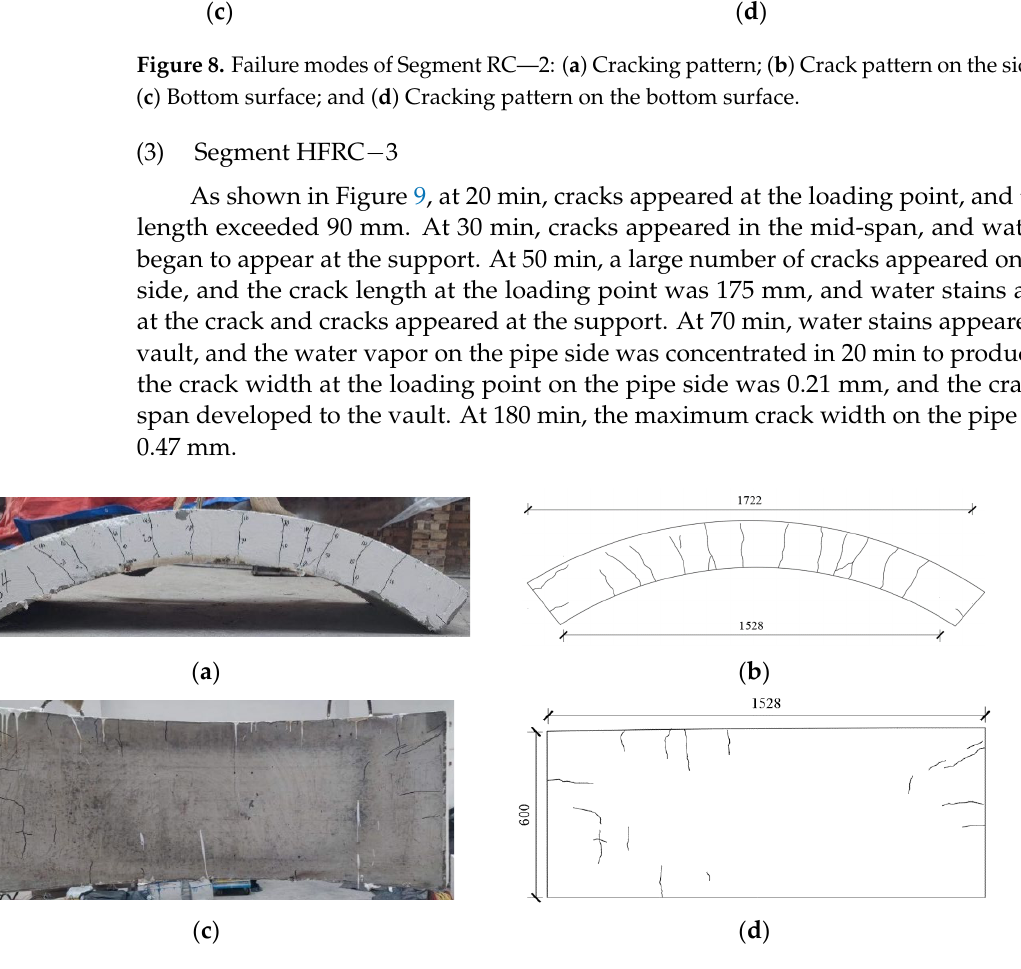
Figure 9. Failure modes of Segment HFRC—3: ( a ) Cracking pattern; ( b ) Crack pattern on the side surface; ( c ) Bottom surface; and ( d ) Cracking pattern on the bottom surface.